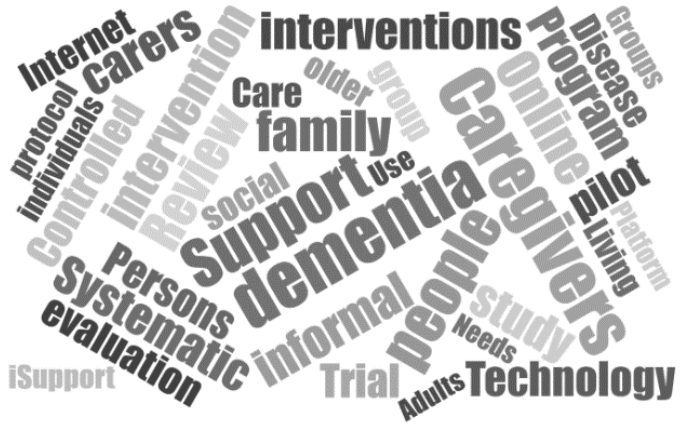
Figure 2. Word Figure 2. Word cloud.